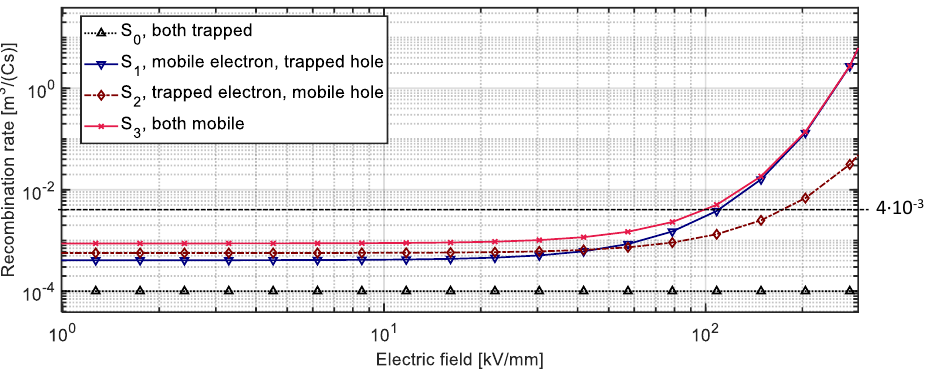
Figure 8. Field dependent recombination rates at 25 °C. The field and temperature dependencies originate from the mobility expressions.